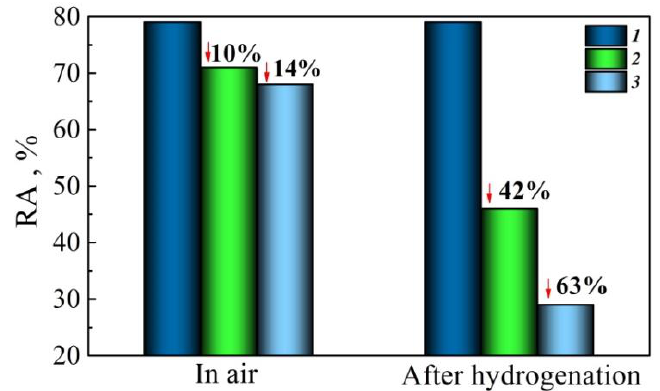
Figure 10. Changes in reduction in area RA for the 17H1S steel under the tensile tests: 1 – as-received steel; 2, 3 – operated for 30 and 40 years, respectively.